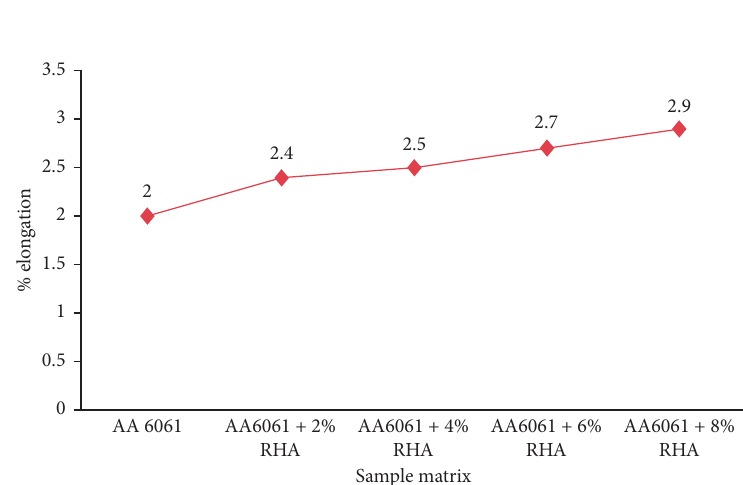
Figure 10: Effect of RHA particles on tensile strength.